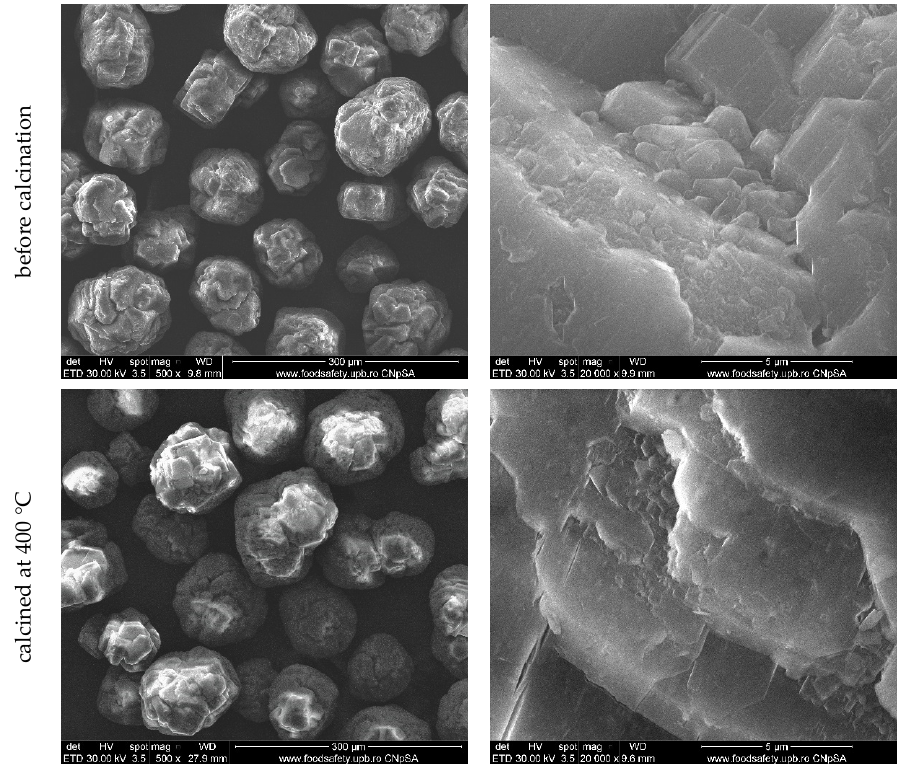
Figure 6. SEM images of the GDAH-05 powder before the thermal treatment and after calcination at 400 °C.